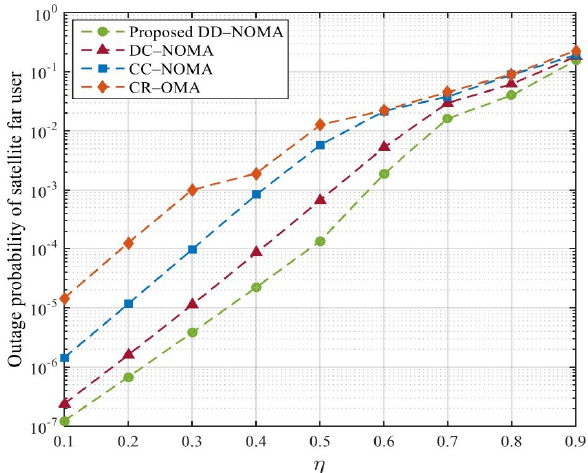
Figure 11. Outage probability of satellite far users under different η